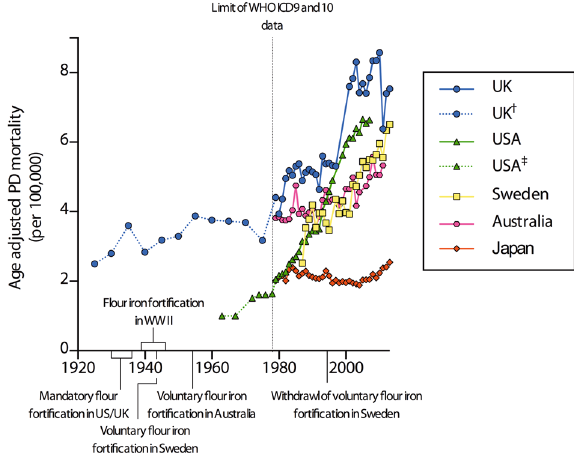
Fig. 1 Age-adjusted mortality rates for PD in males and females from selected high-income countries. All data were obtained from the WHO mortality database (http://www.who.int/healthinfo/mortality_data/en/) and were age-adjusted to the year 2000 population for each country. Increasing PD mortality is most marked in the UK and USA approximately 50 – 65 years following initiation of mandatory iron forti fi cation of grains and milled fl our (1980 – 1995). Japan, with no policy on iron forti fi cation, shows relatively stable mortality rates. PD as the cause of death was de fi ned according to the ICD10 code G20 or ICD9 code 332 (both PD). Figures from the UK for 1984 – 1992 were corrected for dual listing of PD as a chronic condition and a cause of death reported by the Of fi ce of Population Censuses and Surveys to the WHO, as suggested by Clarke. 29 Although WHO mortality data extend only to 1979, Clarke showed that age-adjusted PD mortality in the UK was relatively static in the decades preceding 1980 ( † ; dashed blue line ). 29 Pre-1979 mortality data for the US ( ‡ ) was obtained from Hinz et al . 30 and Lilien fi eld et al . 31 Note that these fi gures are estimates only and are not age-adjusted to the population at 2000. Mortality was used in place of prevalence or incidence rates to remove confounding effects of improving diagnosis or increasing disease duration though medical interven- tion, such as the introduction of L-DOPA treatment in the early